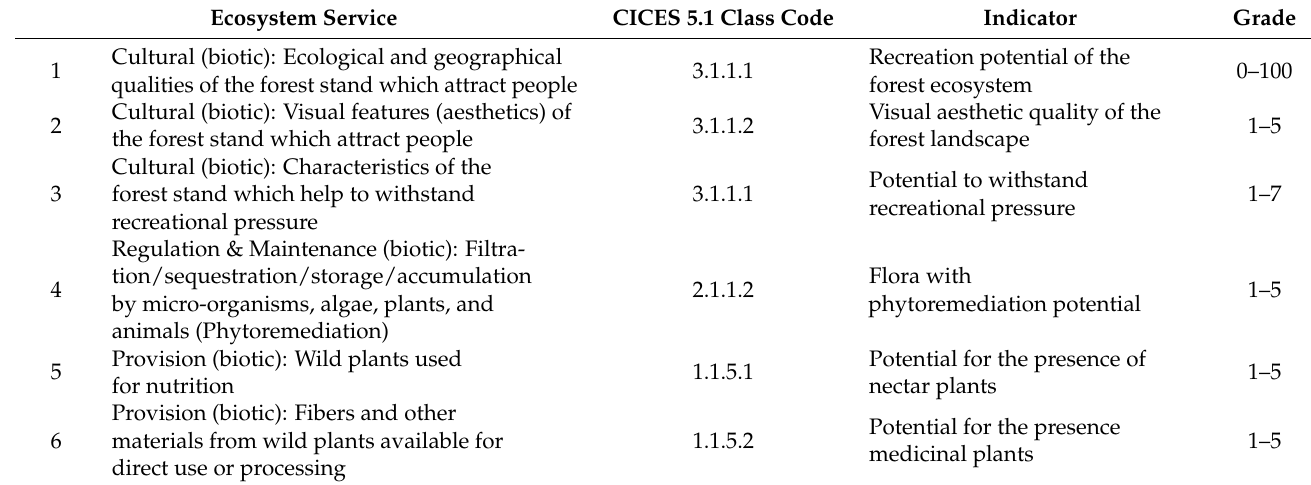
Table 2. Ecosystem services and indicators